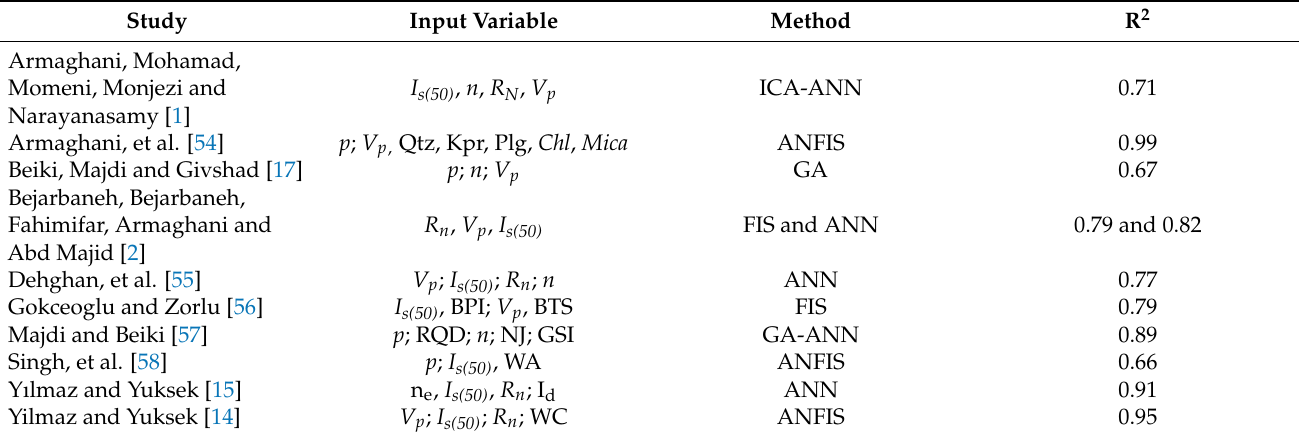
Table 1. Recent studies on the use of machine learning techniques to predict the